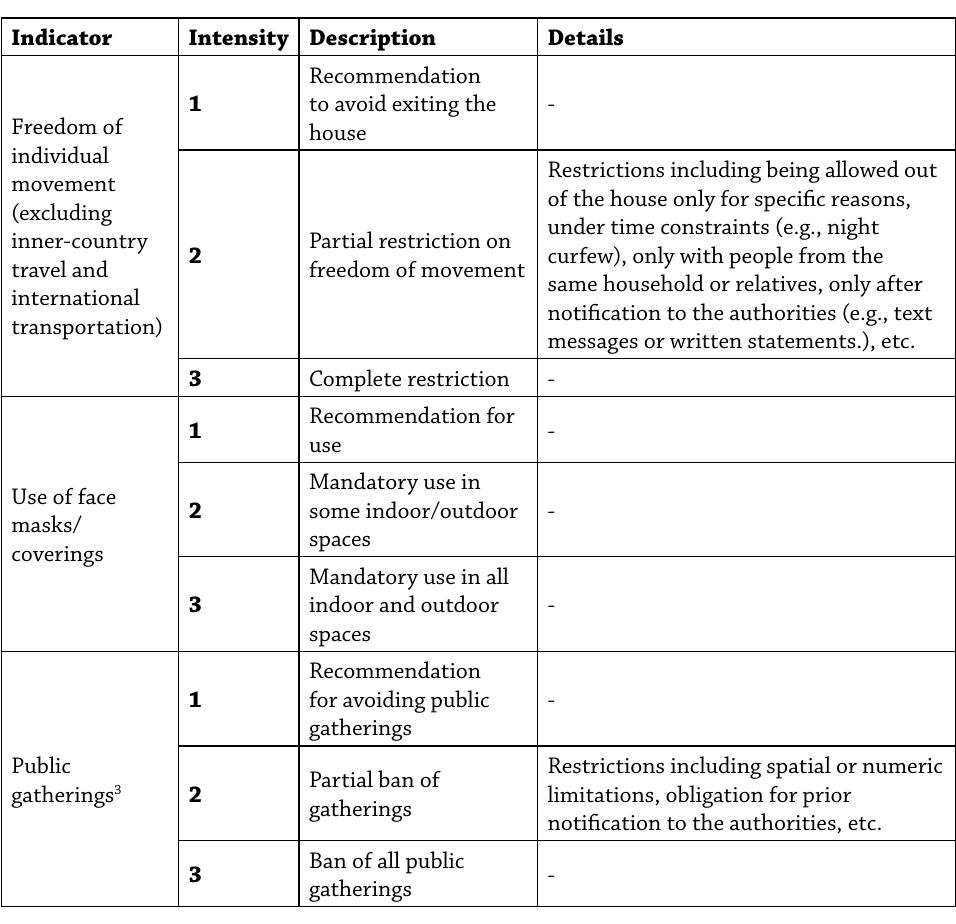
Table 1: GovRM-COVID19 Observatory